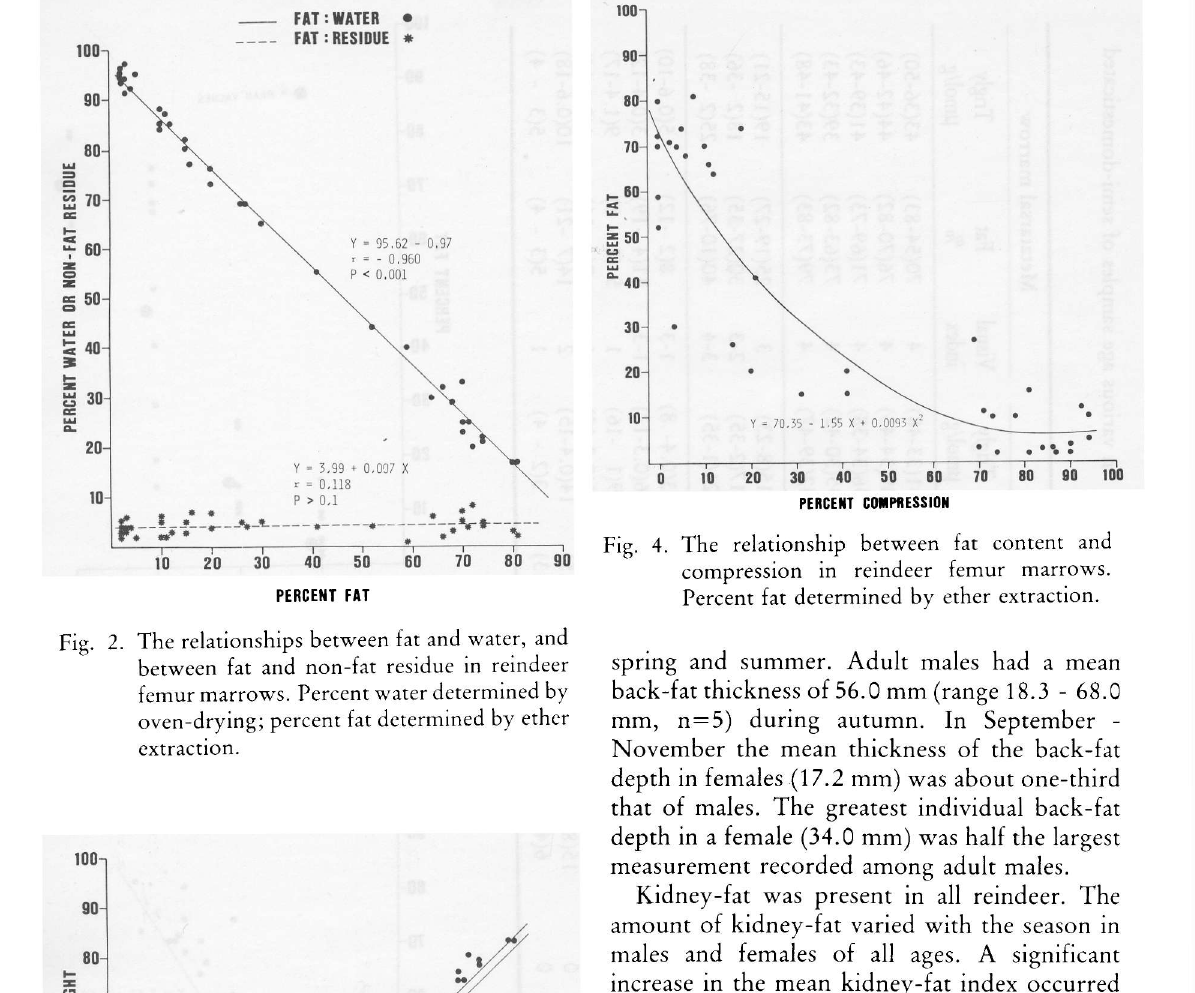
Fig. 2. The relationships between fat and water, and between fat and non-fat residue in reindeer femur marrows. Percent water determined by oven-drying; percent fat determined by ether extraction.